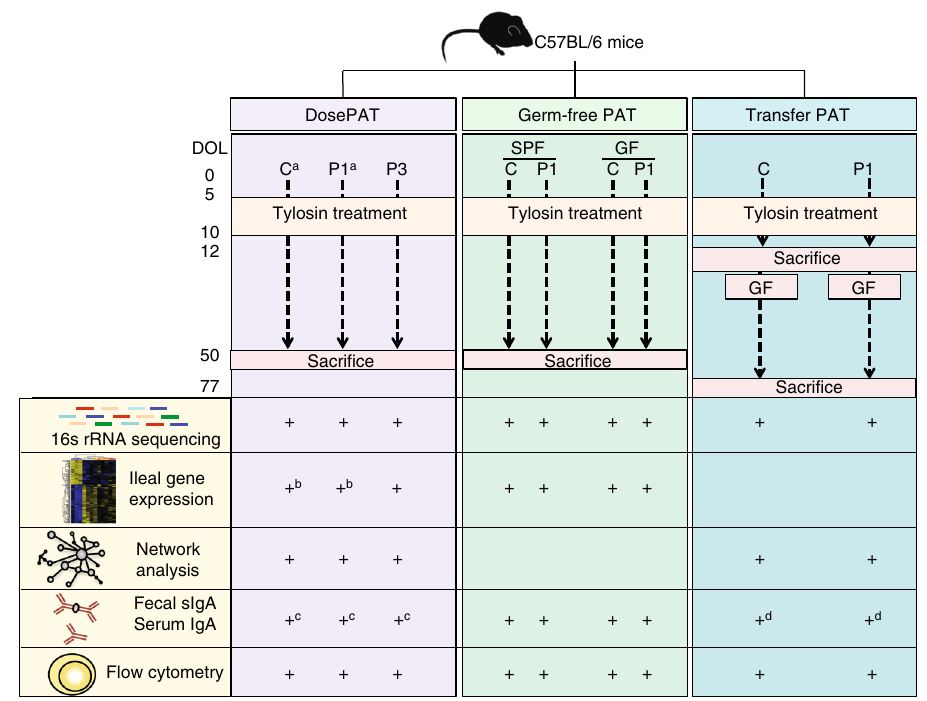
Fig. 6 Schematic of the experiments performed in this study. Footnotes: All + refer to samples collected from pups, except a, samples collected from both pups and dams; b, samples for RNAseq also collected from both pups and dams; c, serum collected at sacri fi ce from both pups and dams; d, IgAseq also performed in both groups of